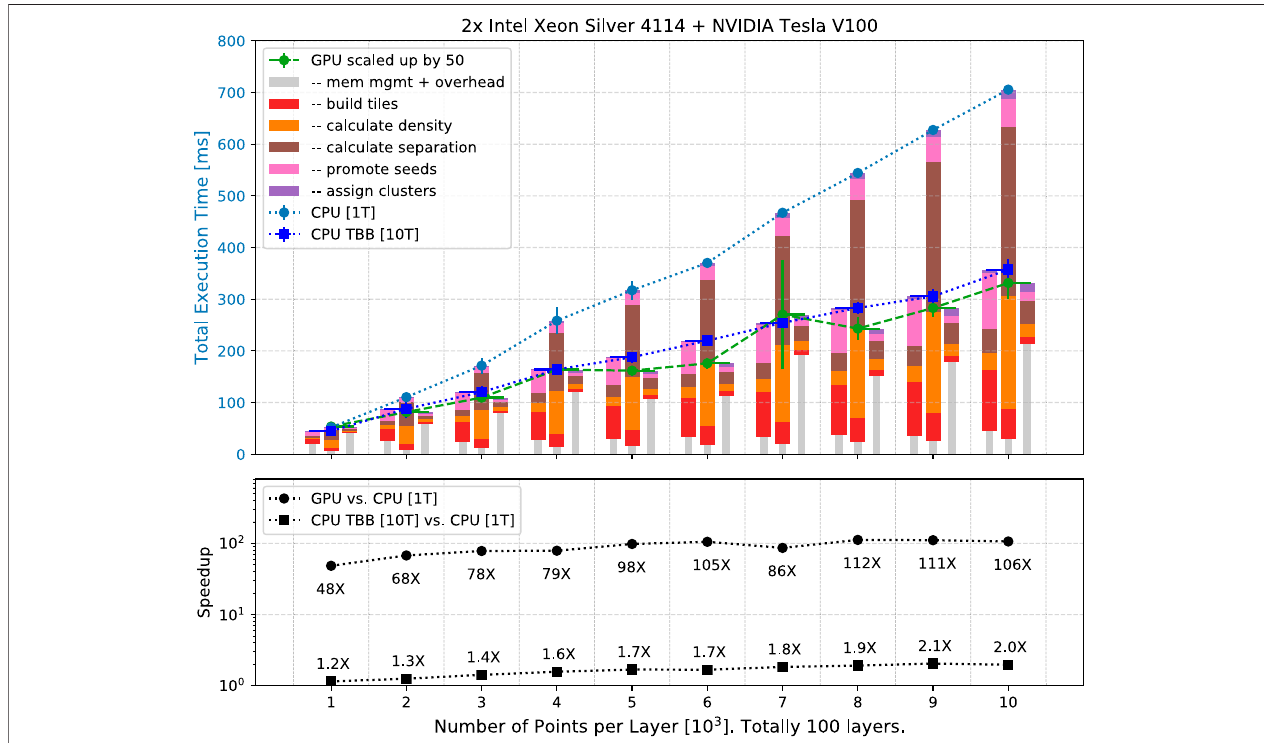
FIGURE 5 | (Upper) Execution time of CLUE on the single-threaded CPU, multi-threaded CPU with TBB, and GPU scale linearly with number of input points, ranging from 10 5 to 10 6 in total. Execution time on single-threaded CPU is shown as blue circle dots and on 10 multi-threaded CPU with TBB is shown as blue square dots, while the time on GPU is shown as green circle dots, scaled up by a factor 50 to fi t the same vertical scale. The stacked bars represent the decomposition of execution time. The gray narrower bars are latency for data traf fi c and memory management; wider bars represent time of essential CLUE steps (Lower) Comparing withthesingle-threaded CPU,thespeed-upfactors oftheGPUrangefrom 48to112,whilethespeed-upfactorsofthemulti-threaded CPUwithTBBrange from 1.2 to 2.0, which is less than the number of concurrent threads on CPU because of atomic pushing to the data containers discussed in Section 3 . Table 1 shows the details of the decomposition of the execution time in the case of 10 4 points per